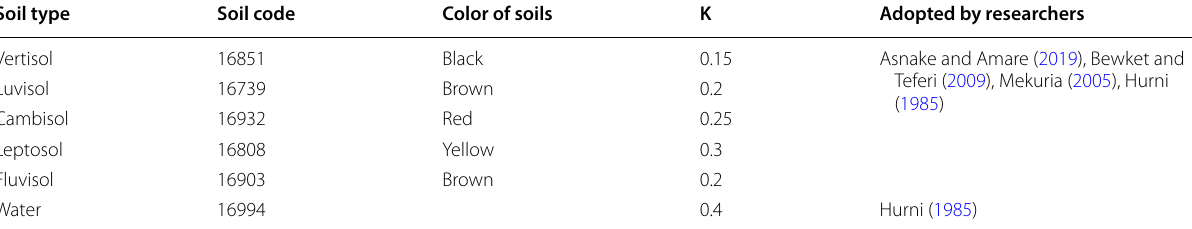
Table 3 Erodibility (K) value of soils of Meki watershed Soil